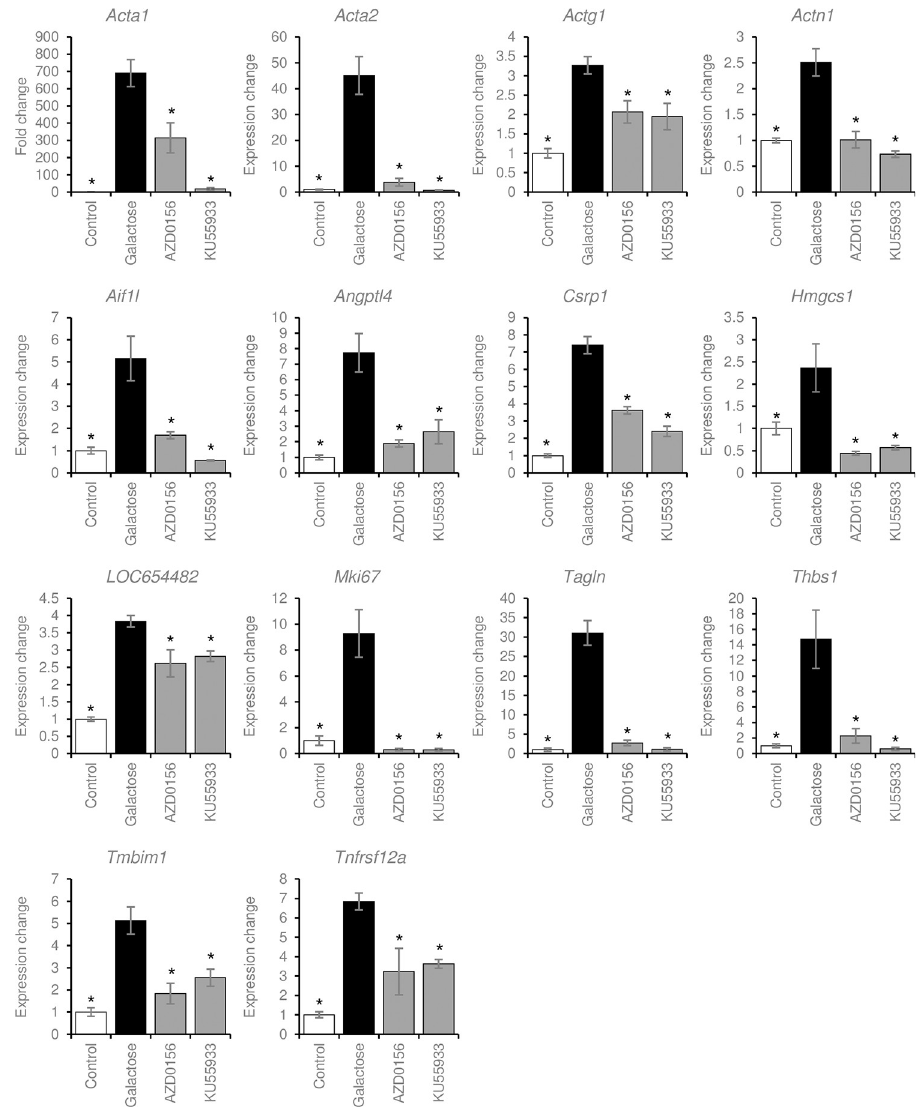
Fig 4. RT-qPCR results for genes with altered expression. RT-qPCR was performed on the 61 genes extracted from microarray analysis. Only the 12 genes that were significantly changed in the Control, AZD0156, and KU55933 groups relative to the Galactose group are shown. Target gene mRNA levels were normalized to Gapdh mRNA levels. Data are expressed as means ± SEM. � P < 0.05 relative to